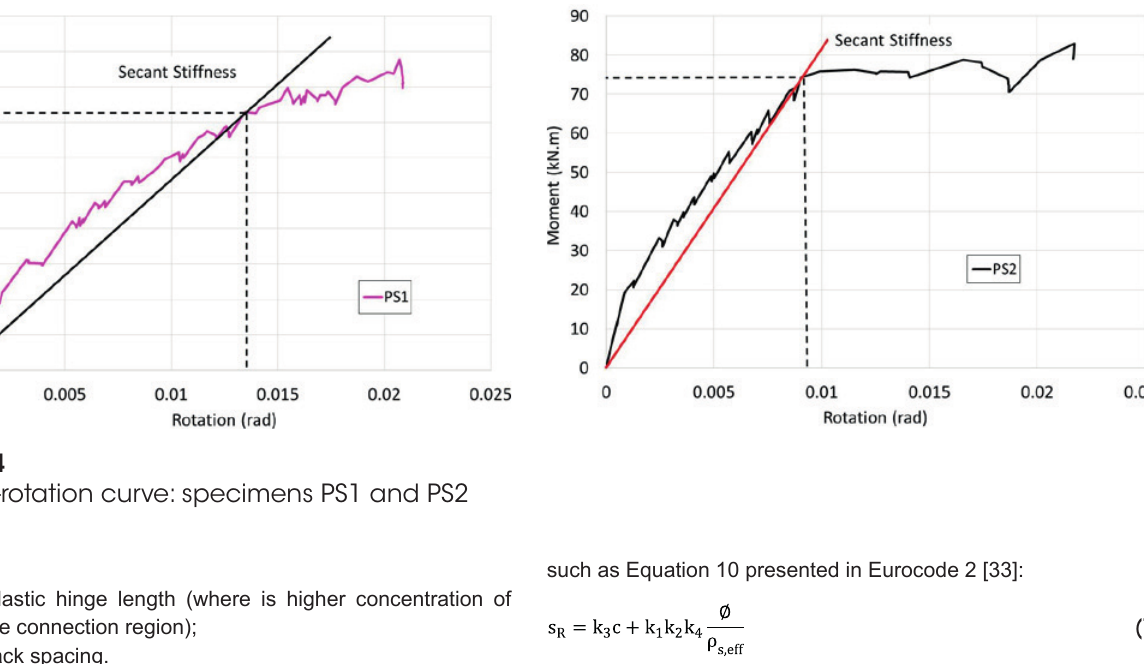
Figure 23 Moment-rotation curve: specimens PC1 and PC2